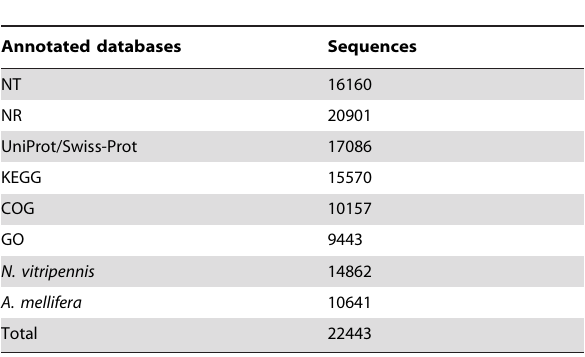
Table 2. Summary of annotations of S. endius